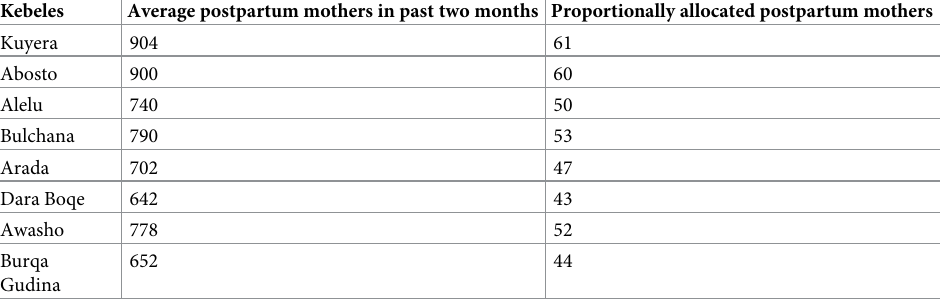
Table 1. Proportionally allocated sample of postpartum mothers in Shashamane town, Oomia, Ethiopia, 2021.